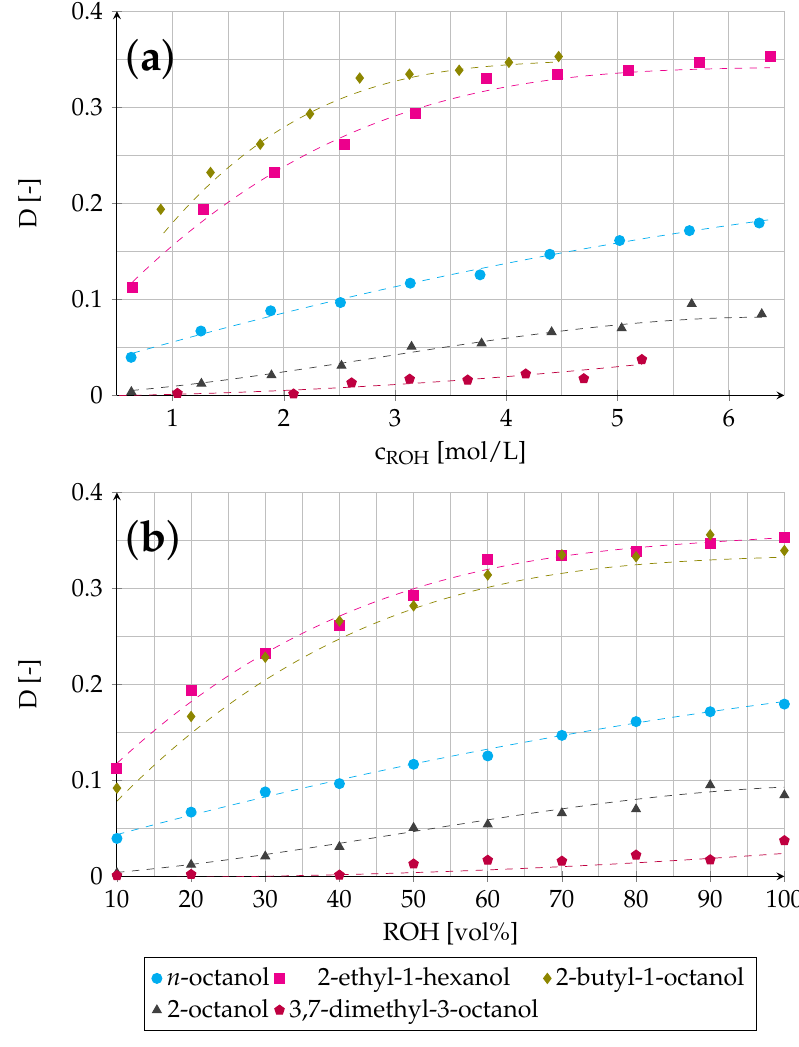
Figure 3. Effect of concentration ( a ) and volume fraction ( b ) of the monohydric alcohol diluted in kerosene on the distribution coefficient (experiment (1) , Table